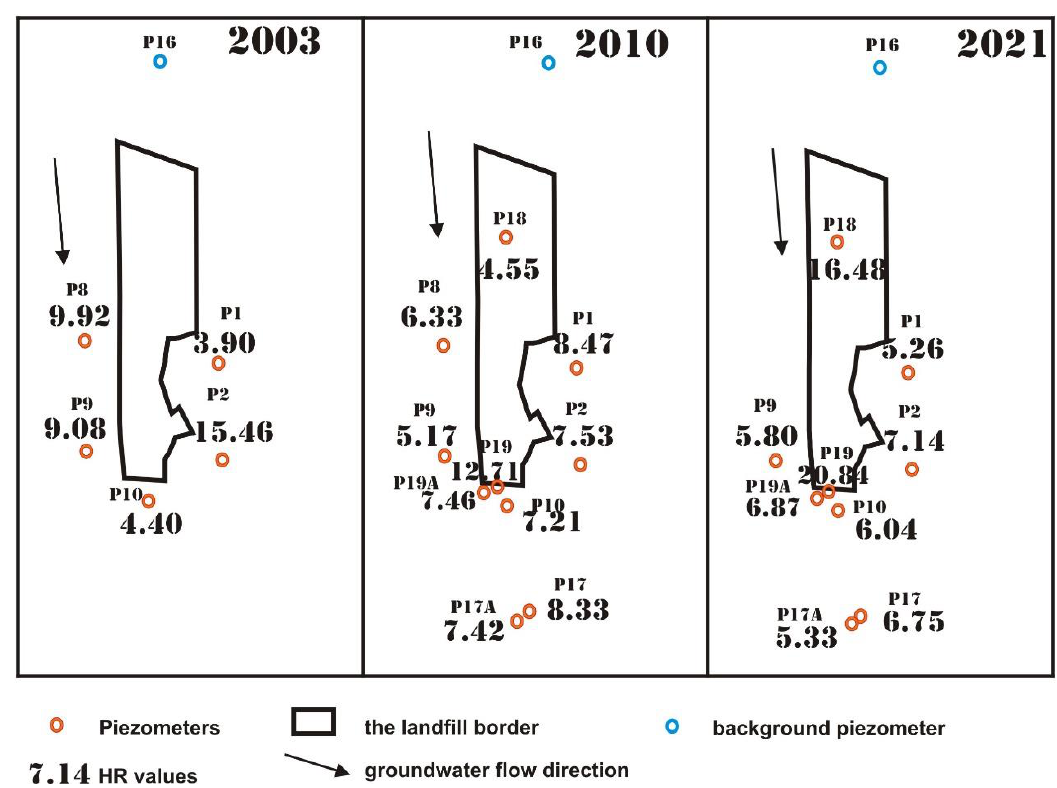
Figure 4. HR index values in years 2003, 2010, and 2021.